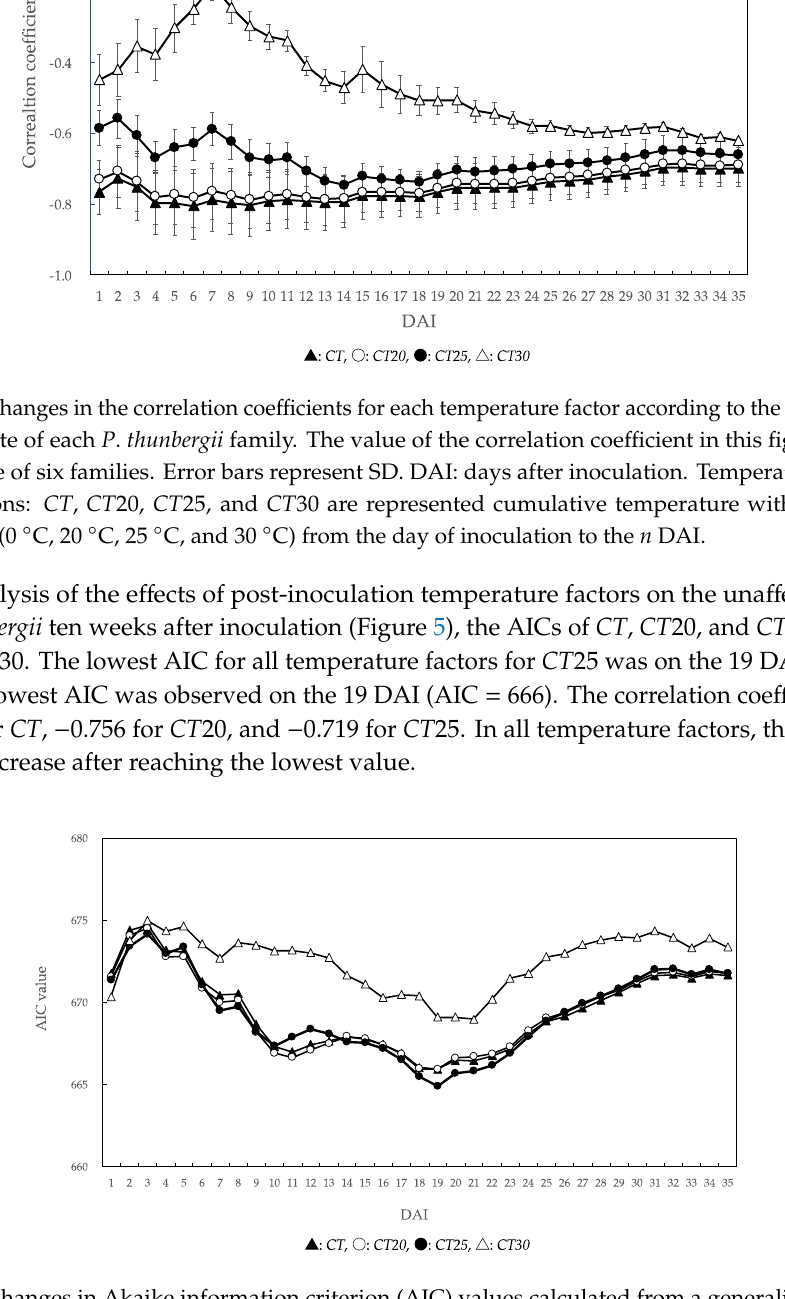
Figure 5. Changes in Akaike information criterion (AIC) values calculated from a generalized linear mixed model including temperature. DAI: days after inoculation. Temperature factor abbreviations: CT , CT 20, CT 25, and CT 30 represented cumulative temperature with different thresholds (0 °C, 20 °C, 25 °C, and 30 °C) from the day of inoculation to the n DAI.